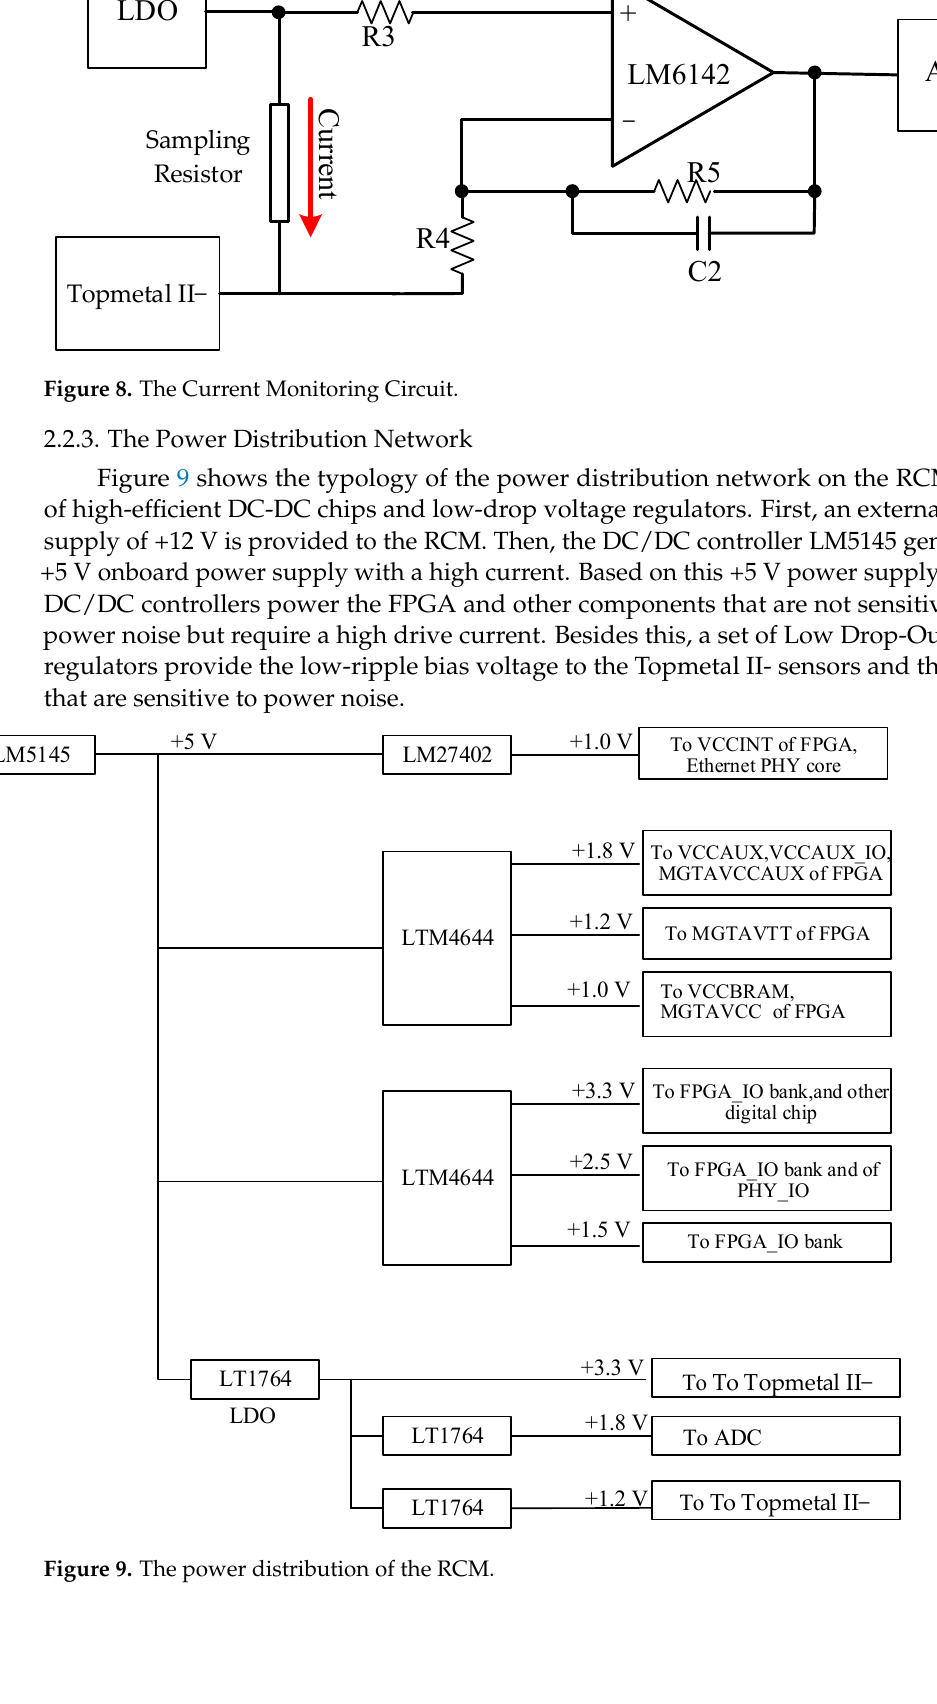
C1 C2 R6From Topmetal II− sensor Figure 7. The analog buffer circuits. 2.2.2. The Current Monitoring Circuit The current monitoring circuit monitors the current of the digital and analog power